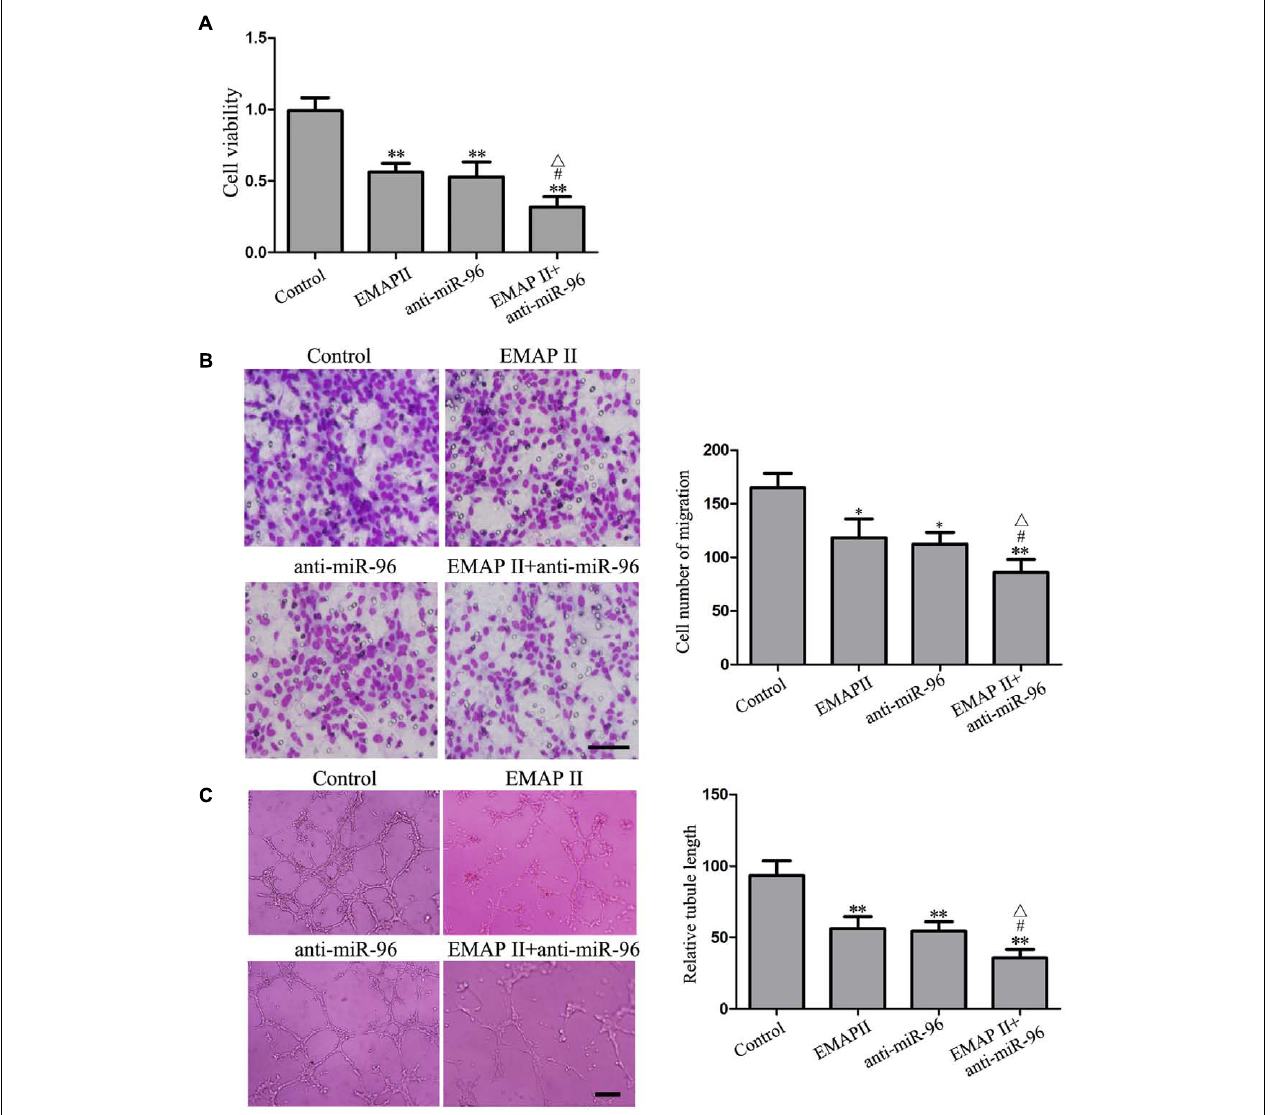
FIGURE 10 | Effects of EMAP II and miR-96 inhibitor on the viability, migration, and tube formation of GECs. (A) CCK8 assay to evaluate the effect of EMAP II and anti-miR-96 on the GECs viability. (B) Transwell assay to evaluate the effect of EMAP II and anti-miR-96 on the GECs migration. Scale bar = 80 µ m. (C) In vitro tube formation assay to evaluate the effect of EMAP II and anti-miR-96 on the GECs tube formation. Data represent means ± SD ( n = 5, each). Scale bar = 100 µ m. ∗ P < 0.05 and ∗∗ P < 0.01 vs. control group; # P < 0.05 vs. EMAP II group; (cid:49) P < 0.05 vs. anti-miR-96